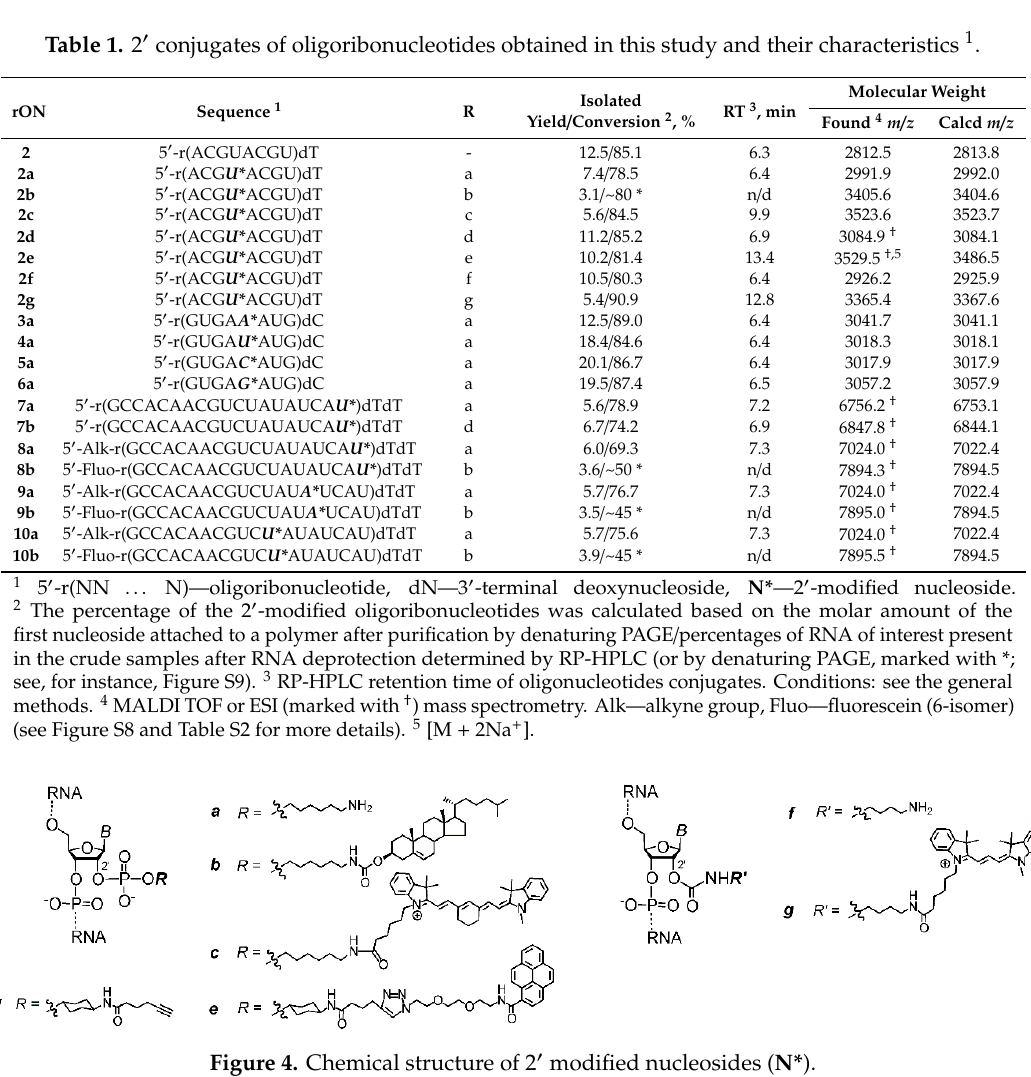
Table 2. Thermal denaturation temperatures (T m values) of duplexes between 3–6 and 3a–6a and complementary or centrally mismatched RNA targets.